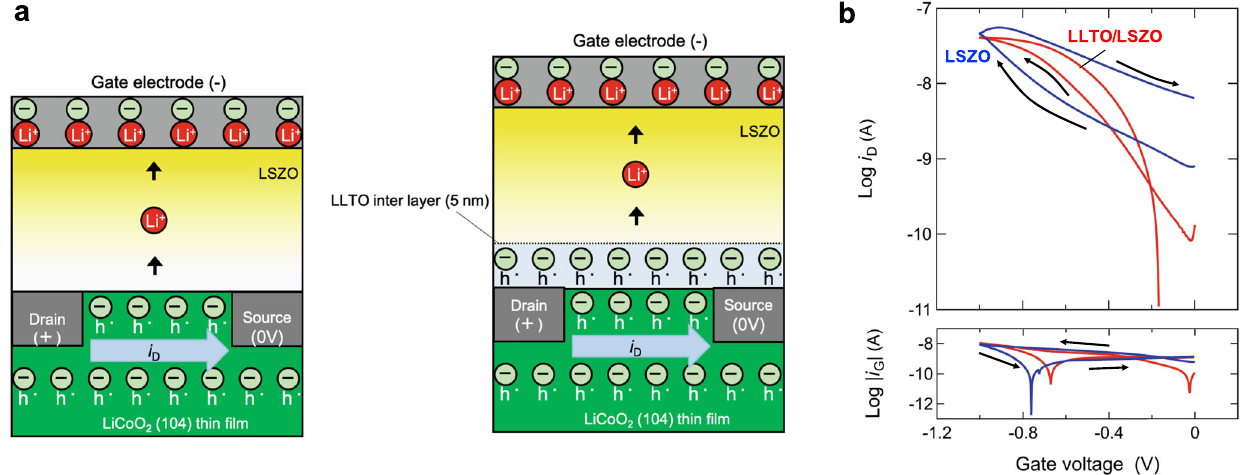
Fig. 4 Comparison with a LiCoO 2 -based redox transistor. a Illustrations of the two LCO-based transistors consisting of LSZO or LSZO/LLTO electrolytes. Li + in the electrolytes shown only as indicators of the polarity of the electric current. b i D vs. V G (upper panel) and i G vs. V G (lower panel) characteristic of the